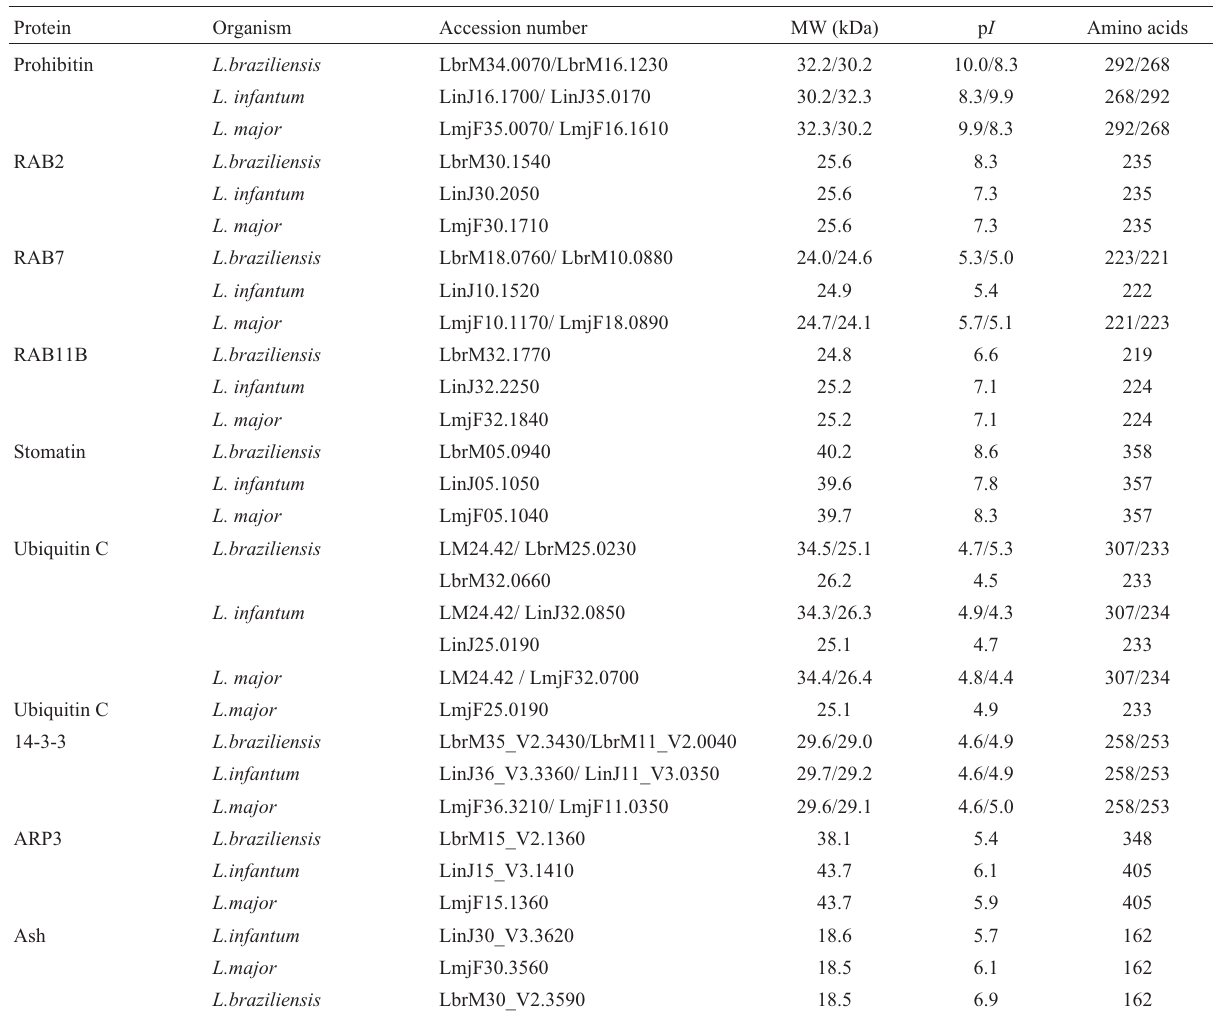
Table 1 - List of selected Leishmania actin-interacting proteins (AIPs) that are seemingly homologous to the phagosome proteins, as described by Garin et al. (2001). The proteins are presented with respective sequence ID (as on GeneDB), length (in number of amino acids), predicted molecular weight and isoelectric point